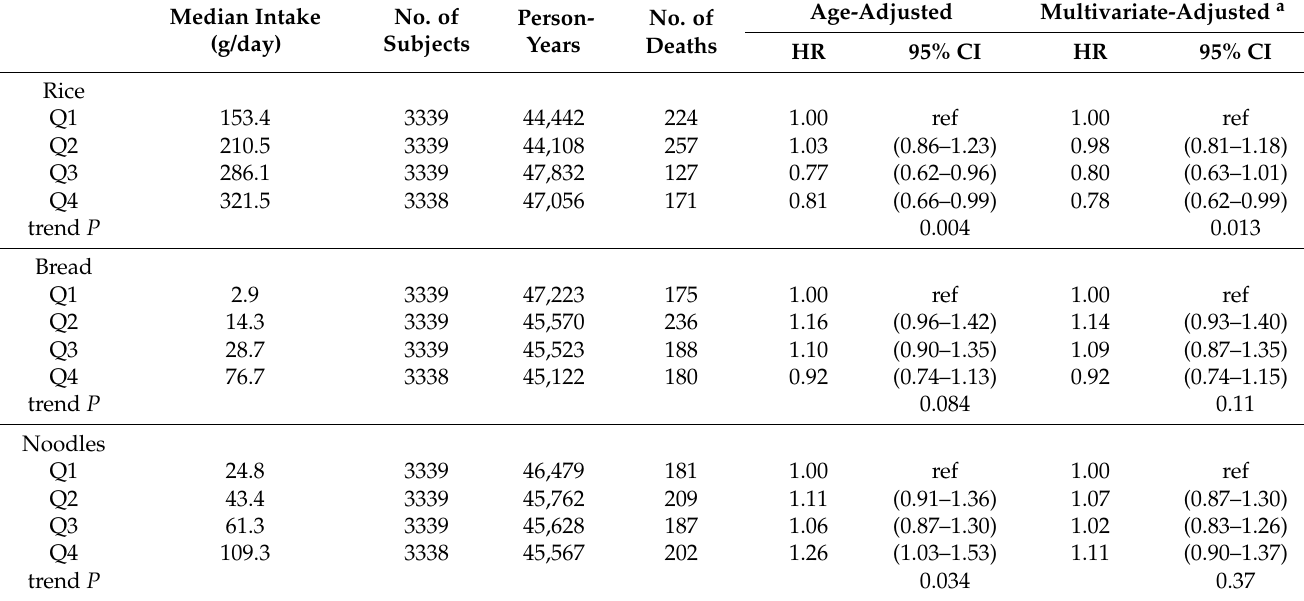
Table 3. Hazard ratios of cardiovascular disease mortality among Japanese men according to the quartiles (Q1–Q4) of intakes of rice, breads, and noodles as grain